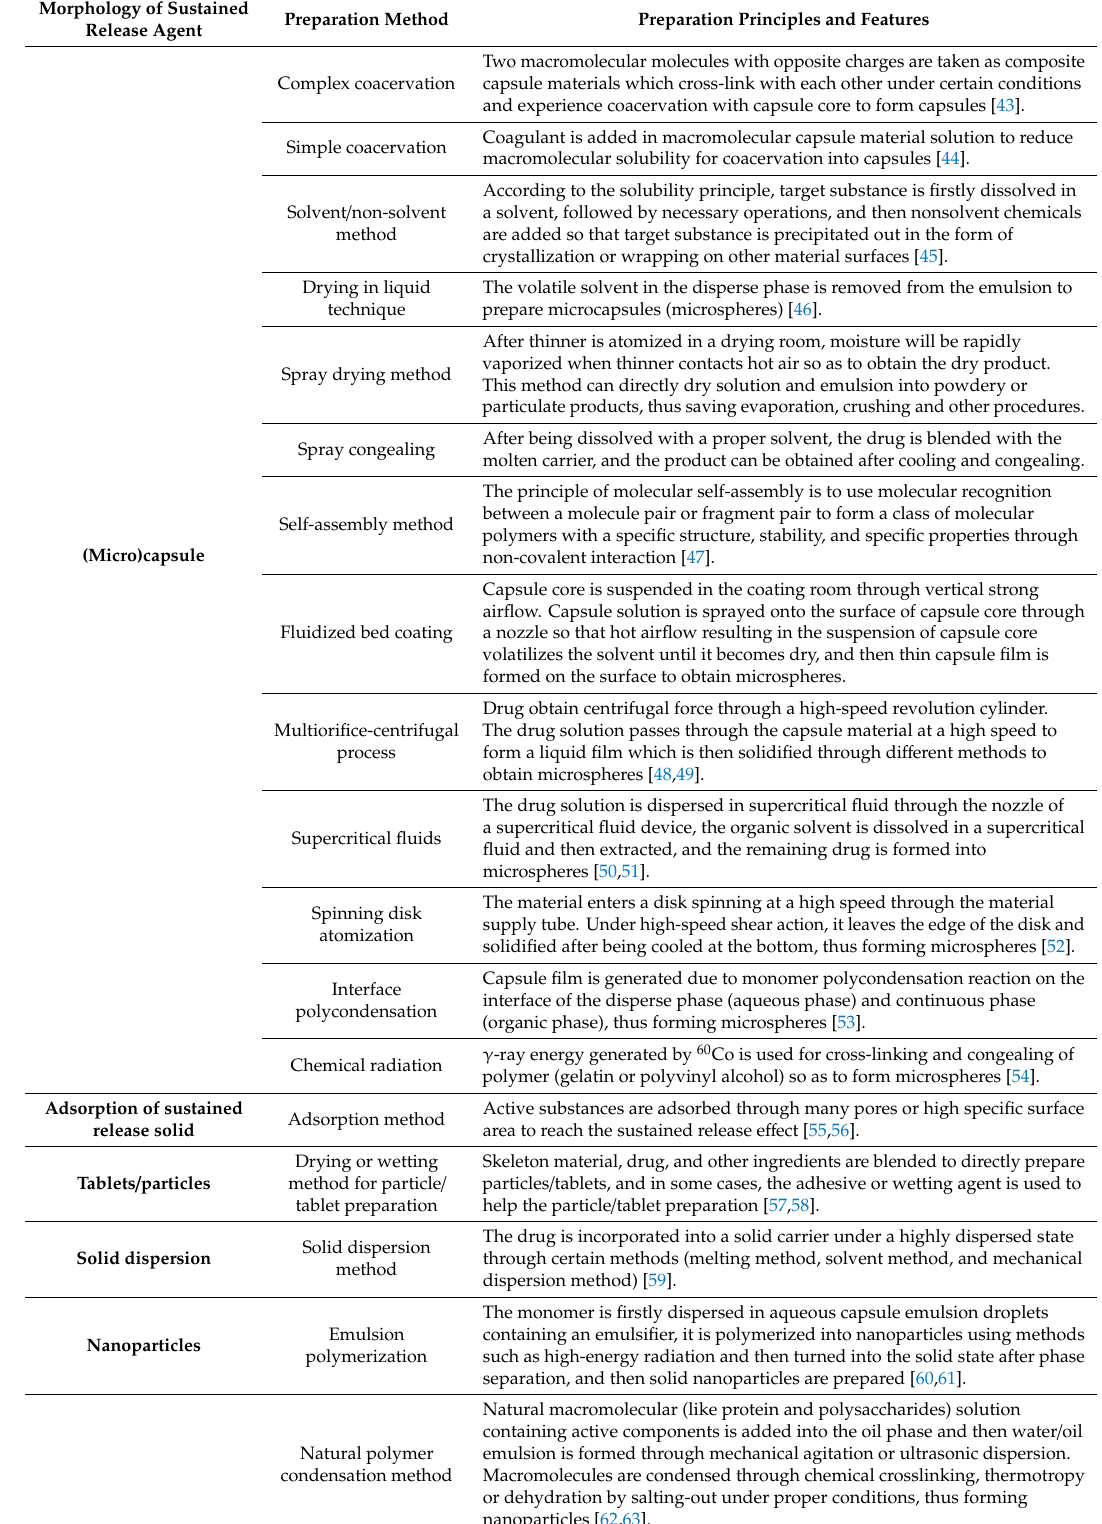
Table 1. Formulation methods and principles of typical sustained release